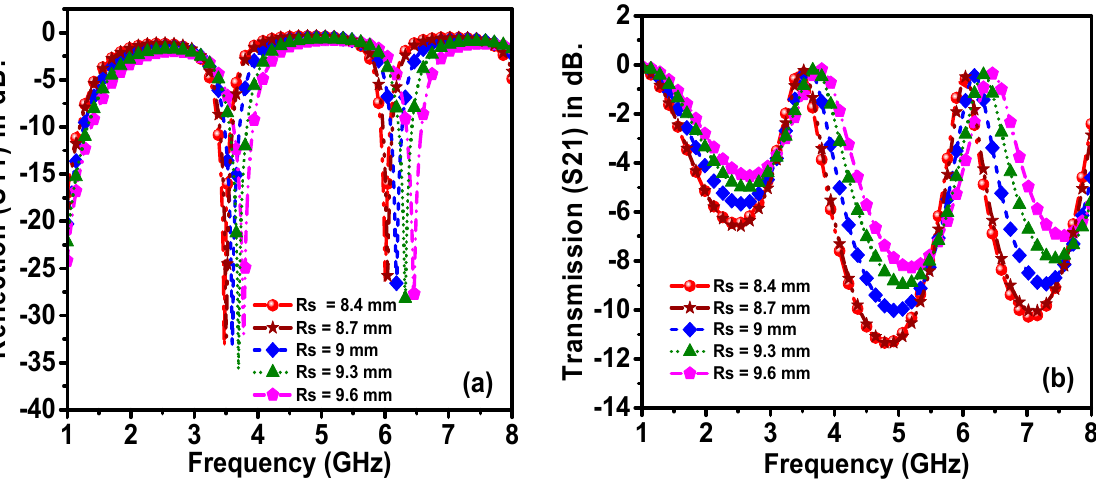
Figure 9. Effect of the sensor layer radius on the resonant frequency of ( a ) reflection and ( b ) transmission spectra.